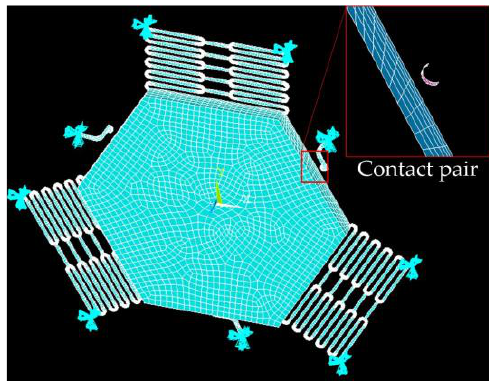
Figure 4. The FE model of the designed three-axis inertial switch.